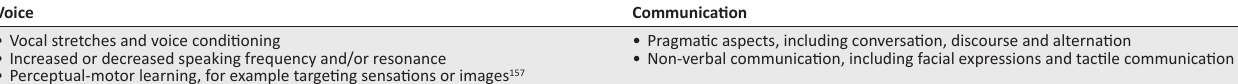
TABLE 11: Voice and communication interventions.